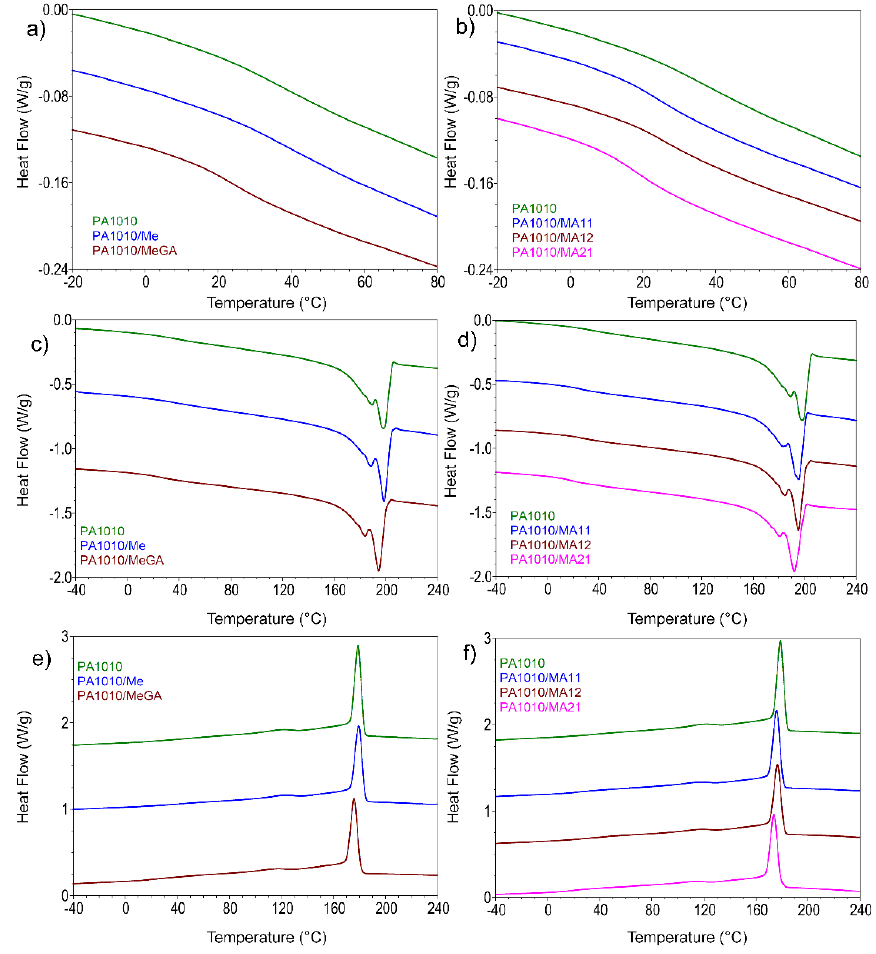
Figure 6. DSC thermograms of PA1010 and its composites with Me/MeGA/MA: second heating curves: ( a,b ) from −20 to 80 °C; ( c,d ) from −40 to 240 °C; ( e,f ) cooling curves.